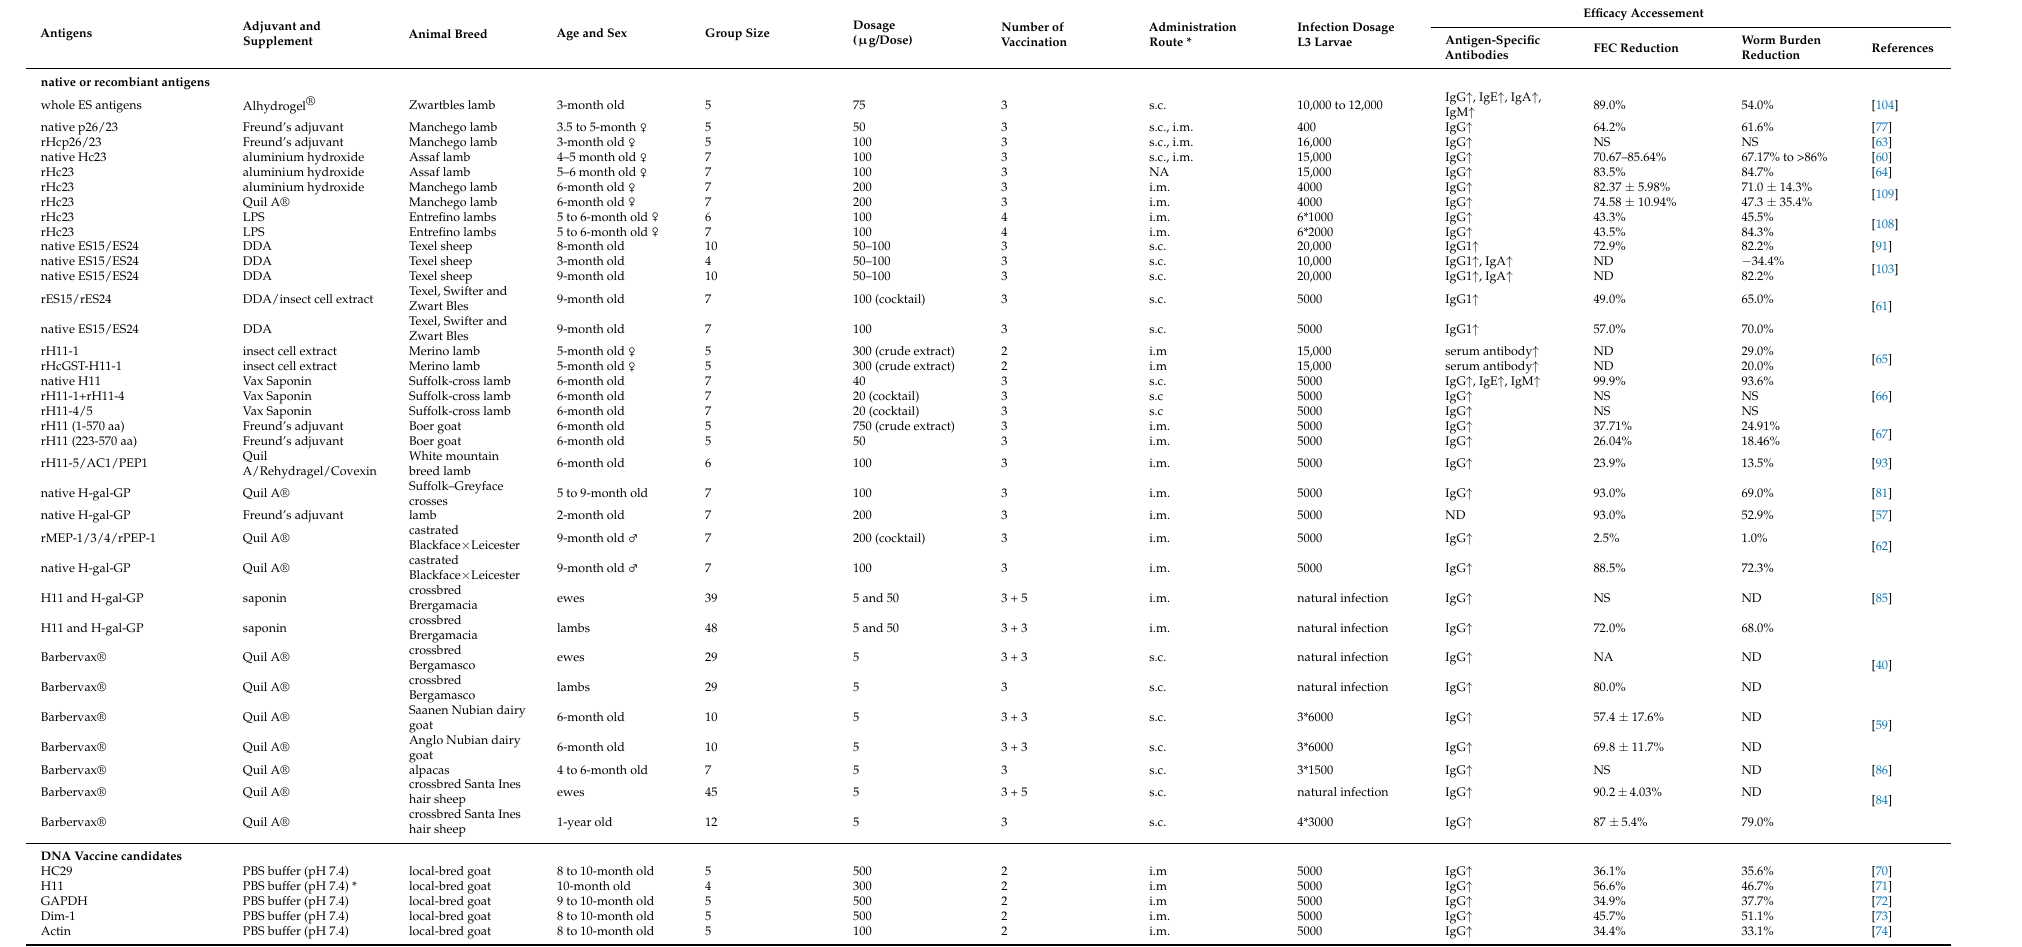
Table 2. Data are extracted from selected vaccine trials in literatures. Changes in antibody, FEC and worm burden are relative to the control group in each trial. Abbreviations: NA not applicable, NS no significant differences, ND no data; DDA, dimethyldioctadecylammonium; LPS, lipopolysacharide; i.m., intramuscular injection; s.c., subcutaneous injection. * Antigen is supplied with plasmid DNA encoding caprine IL-2 (100 µ